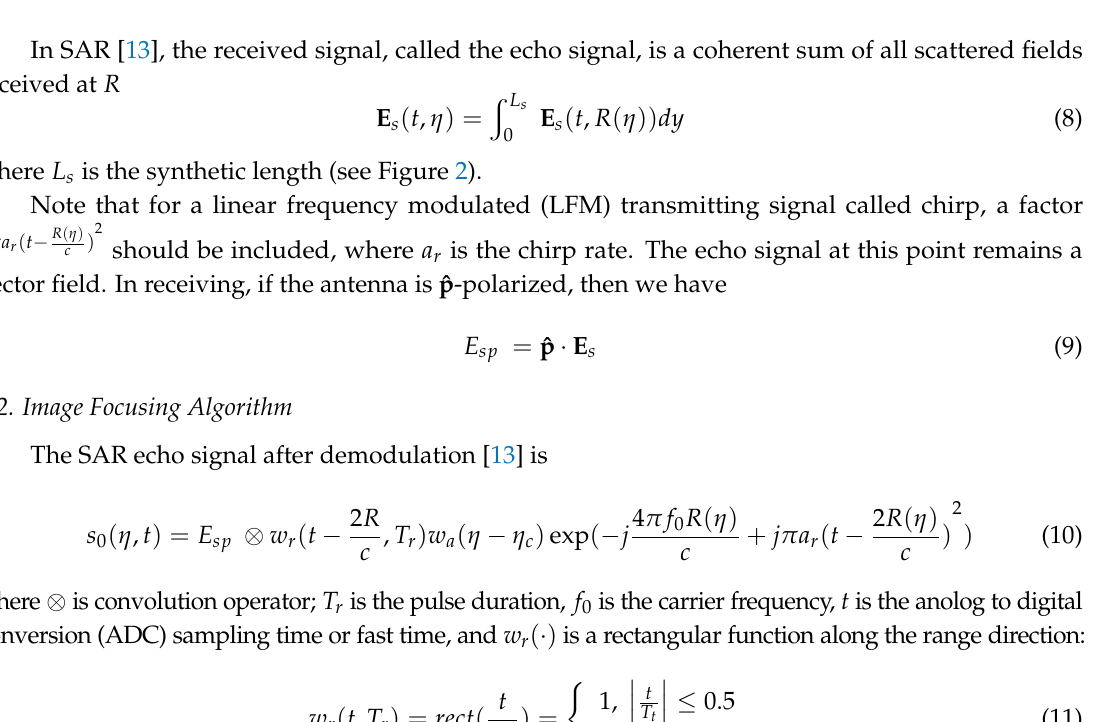
Figure 2. Typical stripmap SAR observation